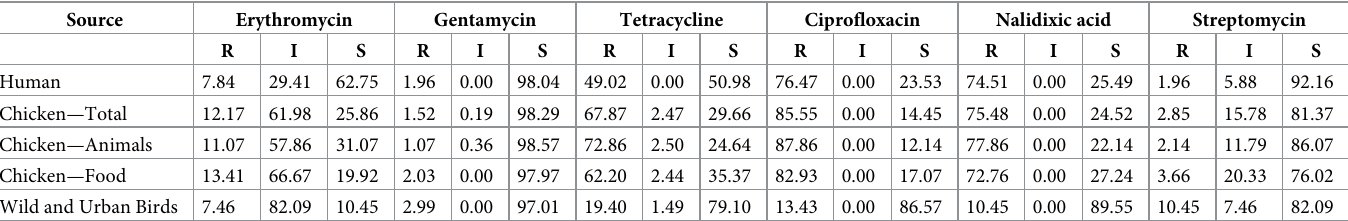
Table 2. Percentage of C . jejuni isolates from humans, poultry and birds from wild and urban habitats displaying different antimicrobial susceptibility levels. Source